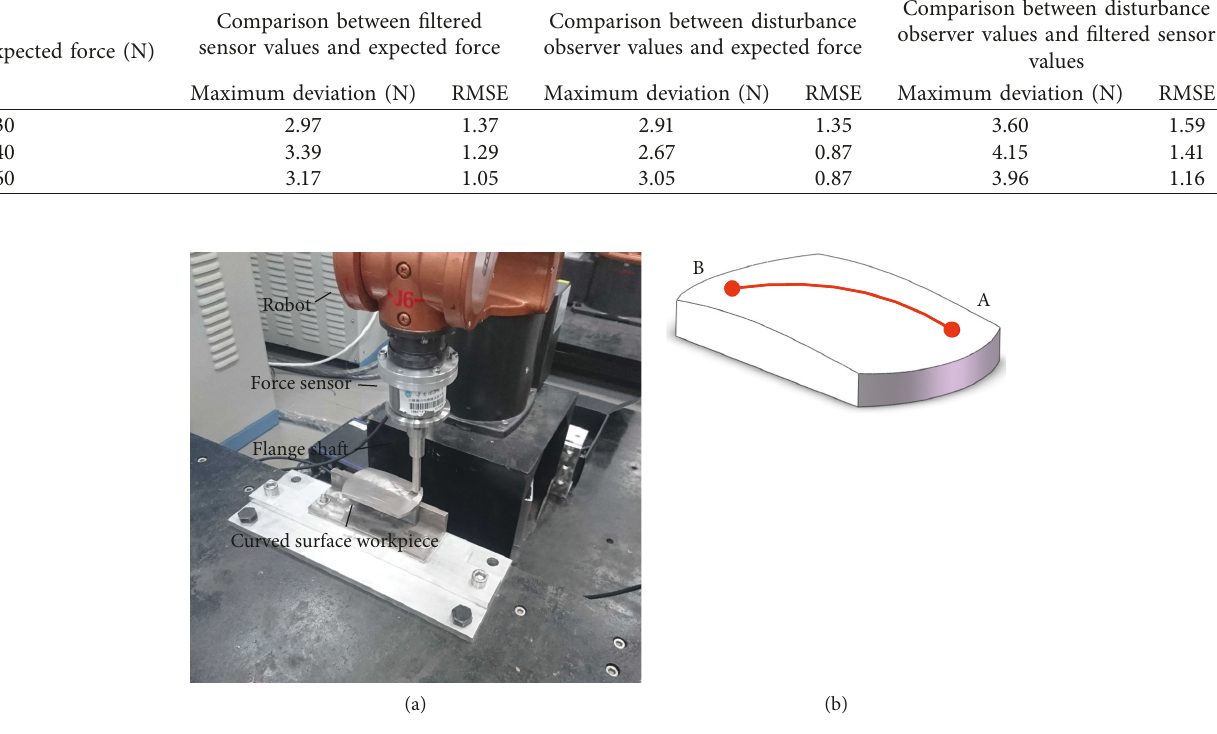
Figure 11: Curved surface workpiece and curved planning trajectory. (a) Experimental device. (b) Schematic diagram of the trajectory.